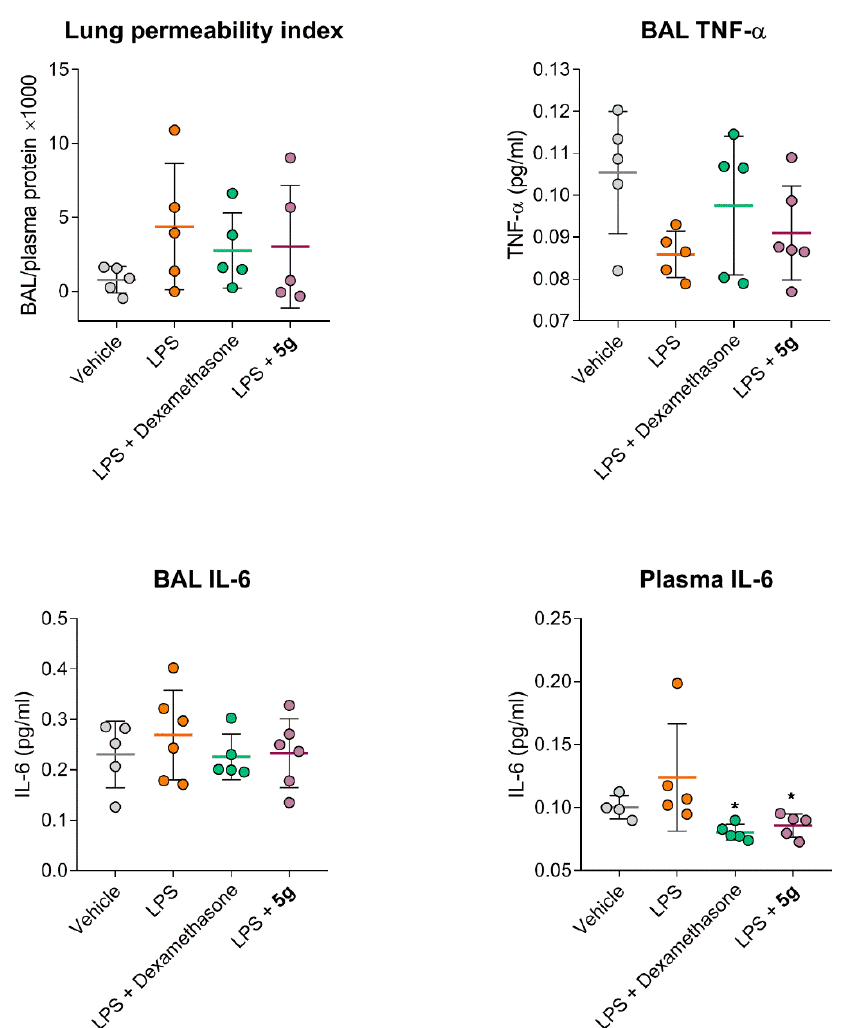
Figure 6. Effect of compounds on biochemical markers of LPS-induced lung injury and inflammation in C57bl/6j mice. Data are shown as mean ± SD; * p < 0.05 (One-directional ANOVA with Dunnett’s post-test). BAL—bronchoalveolar lavage.